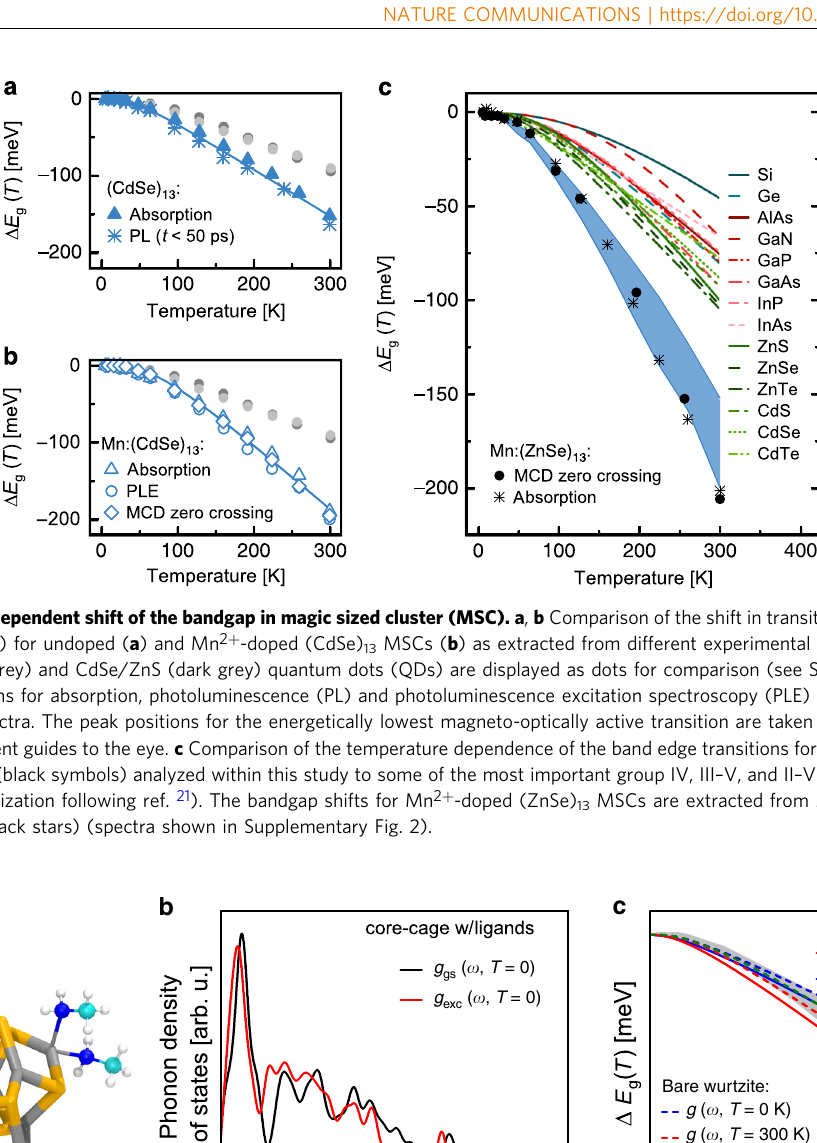
PDOS at 300 K (see Methods). Inserting the ground and excited state PDOSs for T = 300 K, we obtained a slight overestimation for the temperature-dependence of the bandgap (red lines in Fig. 3c). In the case of the sliced-wurtzite (CdSe) 13 MSCs, we then approximated the temperature-dependent PDOS g ( ω , T ) using Gaussian functions as a basis set and interpolated between the PDOSs at T = 0 K and T = 300 K (see “ Methods ” ). As shown in Fig. 3c, the bandgap calculated ab initio from the fully temperature-dependent g ( ω , T ) (green dashed line) is in excellent agreement with the experiments within the whole measured temperature range.